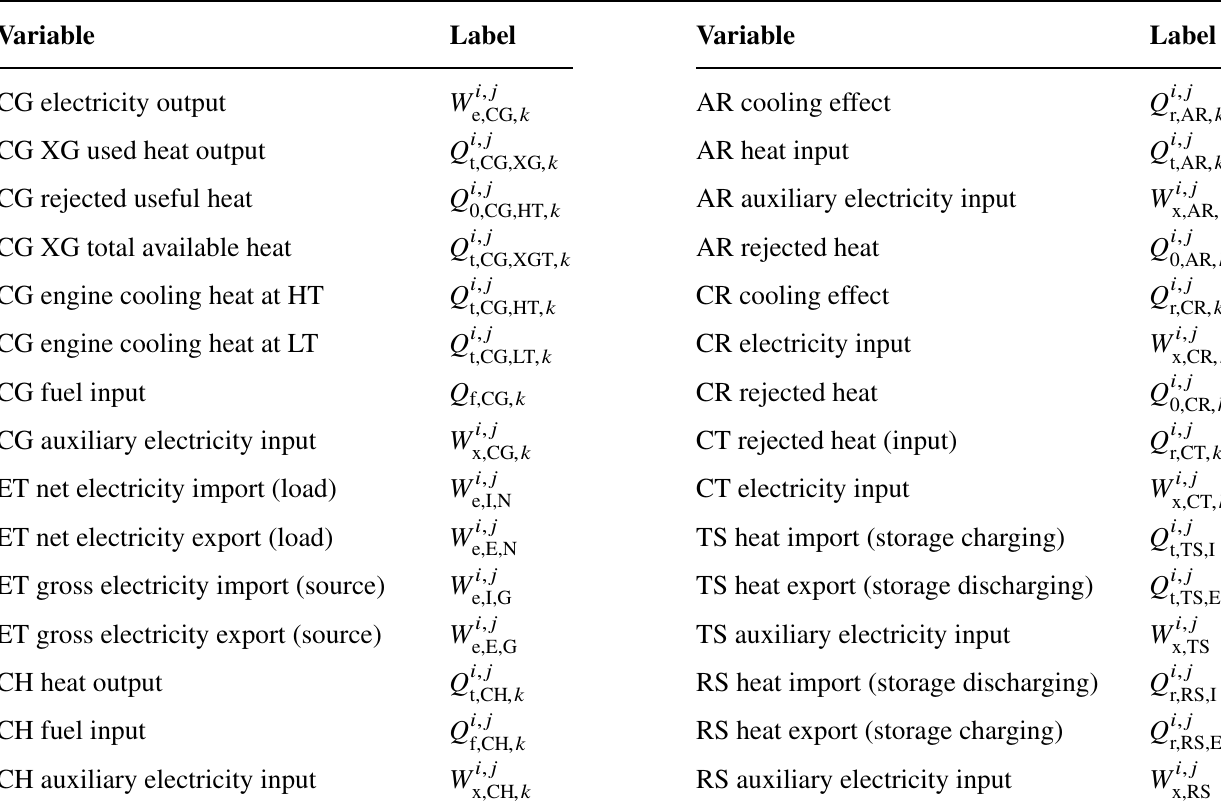
Table 2. Summary of the main additional variables representing energy flows, given in (kWh). Variable Label Variable